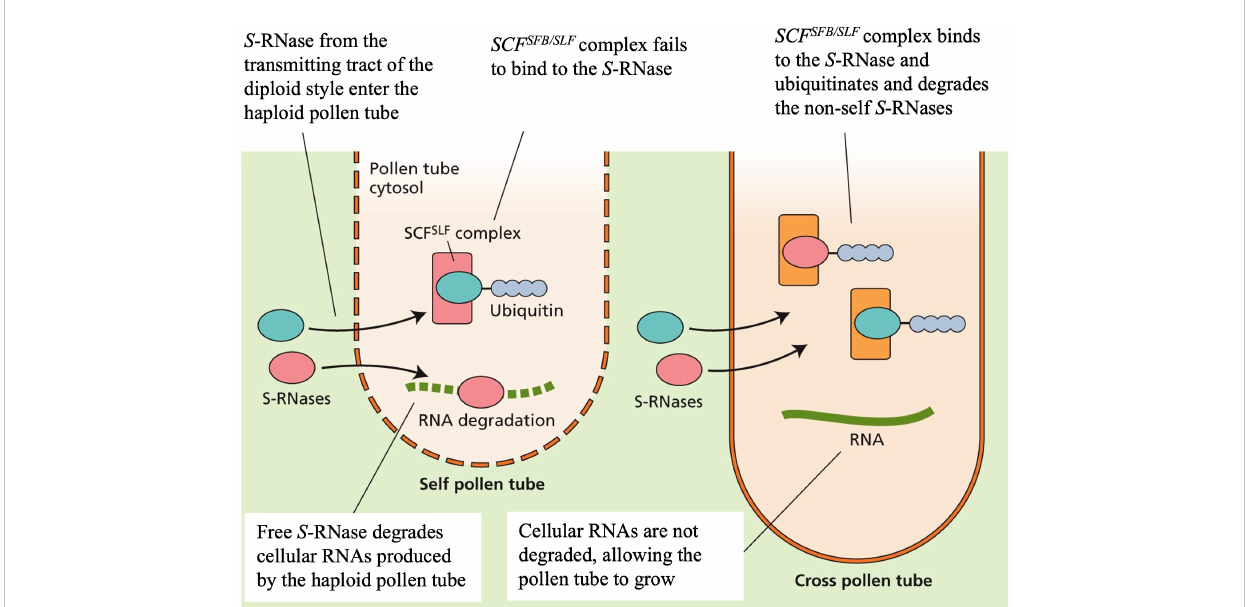
FIGURE 1 Molecular mechanism of gametophytic self-incompatibility (GSI). The pistil Sdeterminant is speci fi ed by cytotoxic S-glycoproteins or S-RNase gene expressed in the transmitting tissue of the style. S-RNase from the diploid style enters the haploid pollen tube. In cross-pollinated fl owers (right in the Figure), the SCF SFB/SLF complex binds to the S-RNase, which ubiquitinates and degrades the non-self S-RNases. Such degradation of the S-RNase prevents cellular RNAs degradation caused by S-RNase, allowing the pollen tube to grow. In self-pollinated fl owers (left in Figure), the SCF SFB/SLF complex fails to bind to the S-RNase, resulting in cellular RNAs degradation by the free S-RNase, leading to block pollen tube growth. Figure is reproduced with permission of the Licensor through